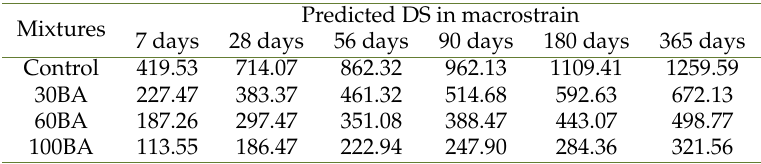
Table 9. Percentage of difference amongst investigational and forecast values of DS.